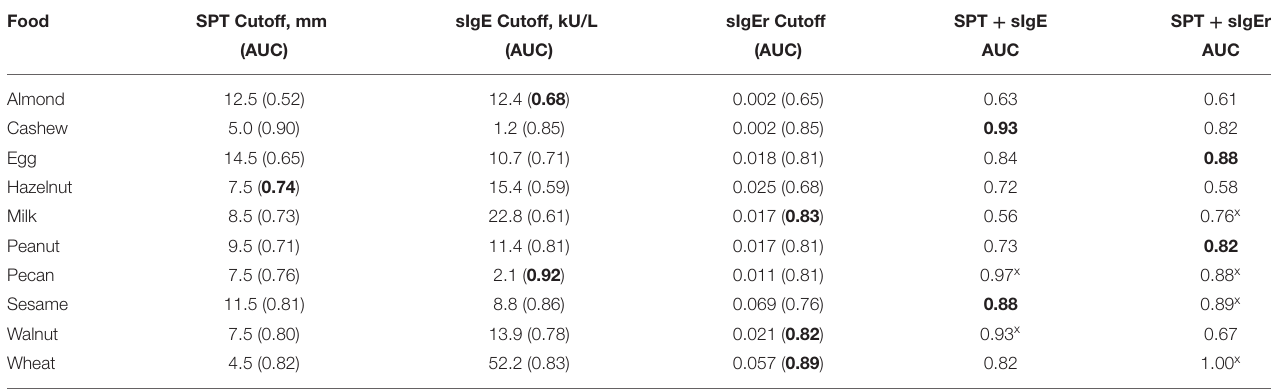
Based on ROC analysis of challenge outcome. Bolded values indicate the highest AUC across all markers, excluding those with an x. x Denotes quasi-separation/non-convergence of model. AUC from these models may not be informative. Subjects with negative challenge outcomes were not included. SPT, skin prick test; AUC, area under the curve; sIgE, allergen-specific IgE; sIgEr, specific IgE / total IgE ratio.